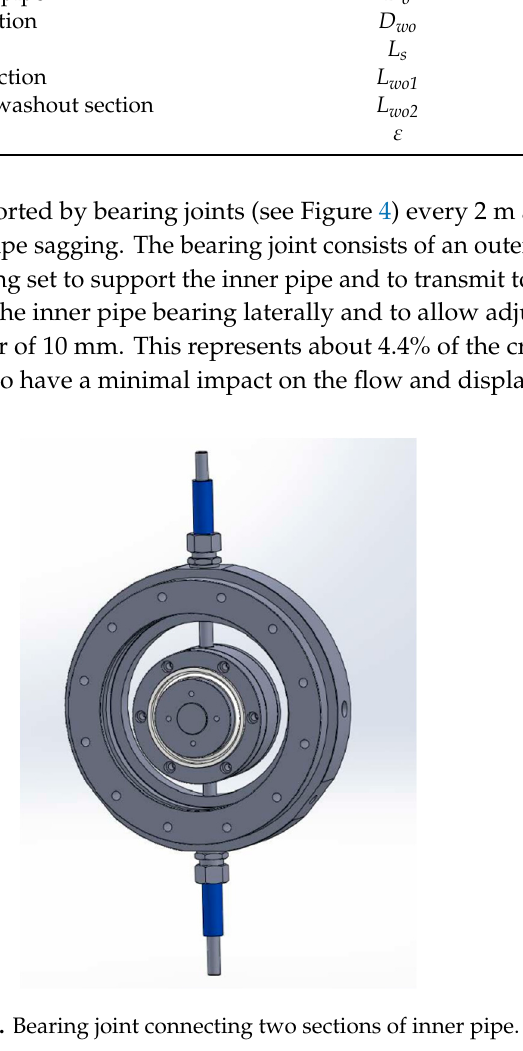
Figure 5. Piping and valves at inlet to test section. The valves V1 and V2 of Figure 2 were controlled from the PC using pneumatic actuators. A drain valve (blue handle) with corresponding hose (not shown in Figure 2) was used to drain the test section after an experiment.